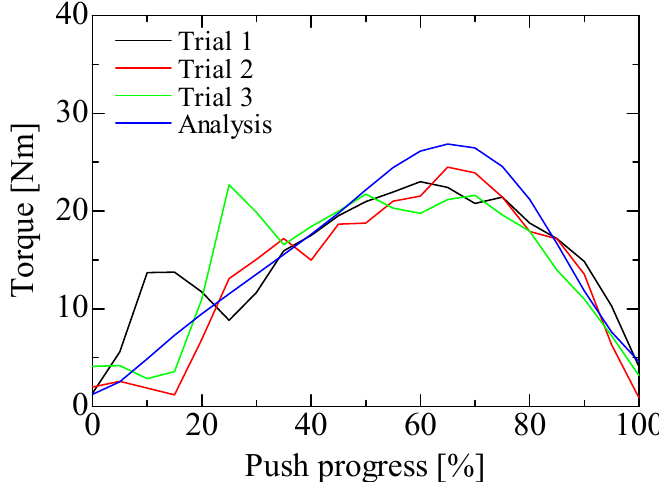
Figure 2. This figure shows the results of the torque data for the experiment (for three trials) and the simulation. The horizontal axis represents Push progress (Pp), which means the normalization time during the push operation (0.2